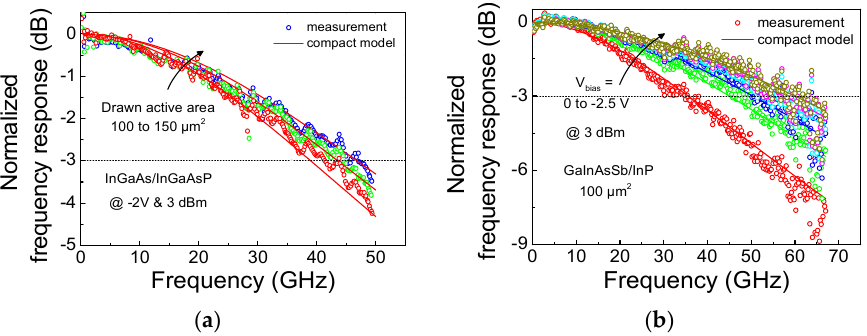
Figure 14. Bandwidths of the UTC-PDs: ( a ) InGaAs/InGaAsP UTC-PDs ( b ) GaInAsSb/InP UTC-PD.